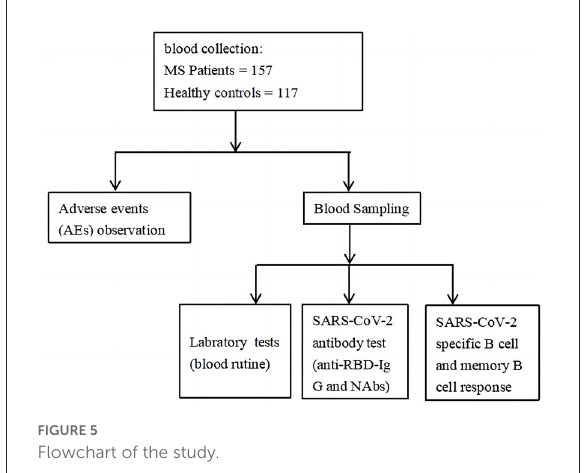
FIGURE5 Flowchart of the